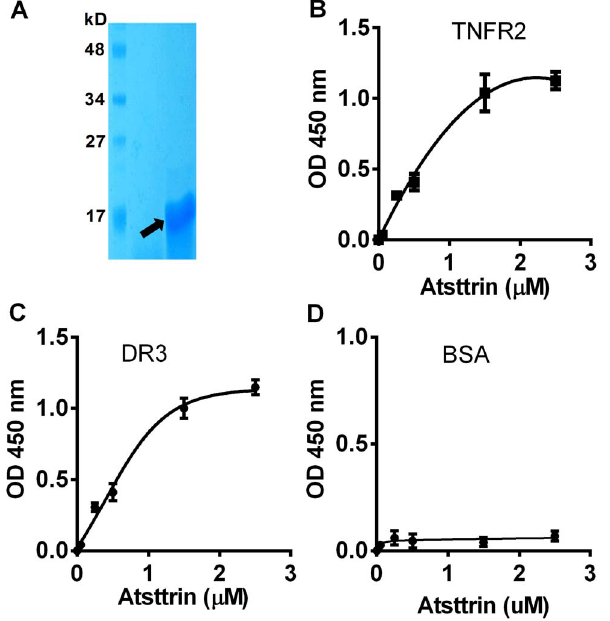
Figure 2. Atsttrin directly binds to TNFR2 and DR3, examined by solid phase binding assay. A. SDS-PAGE analysis of purified Atsttrin. Atsttrin was indicated by an arrow. B and C. Solid phase binding assay. Various dose of Atsttrin was coated to ELISA plate, biotinylated TNFR2 (B), DR3 (C) or BSA (D) was then added to each well, bound protein was detected by adding avidin-HRP to each well and the absorbance was measured at OD 450 nm.